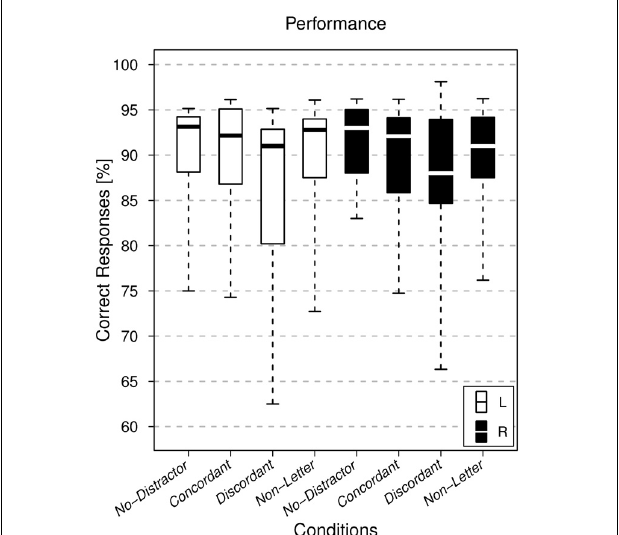
FIGURE 2 | Performance. Boxplot showing the distribution of the individual subjects’ performance, comparing the various task conditions. Conditions corresponding to the attended left ear (L, white) and attended right ear (R, black) runs are shown. The horizontal line within each box represents the